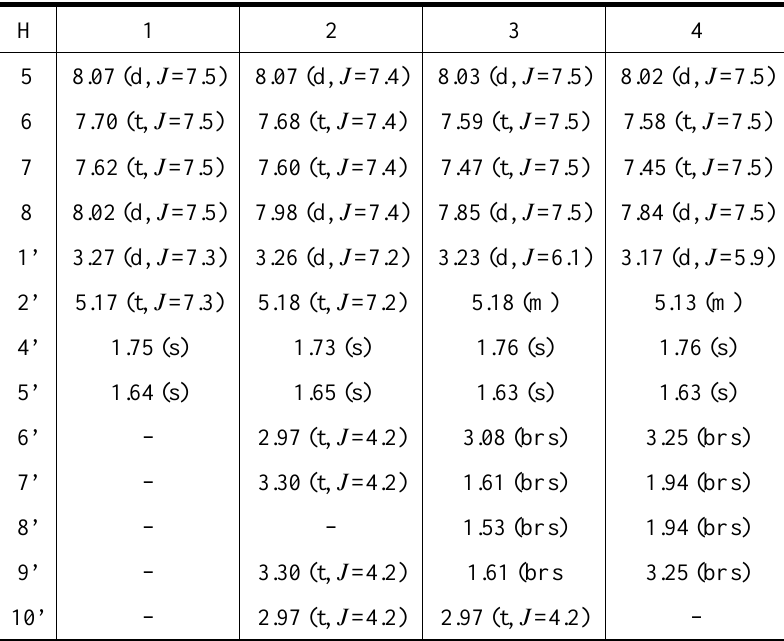
1 H NMR spectral data for lapachol (1) and the enamine derivatives 2-4. Chemical shifts in δ H (ppm) and coupling constants ( J , in parenthesis) in Hz, in CDCl 3 and TMS as internal